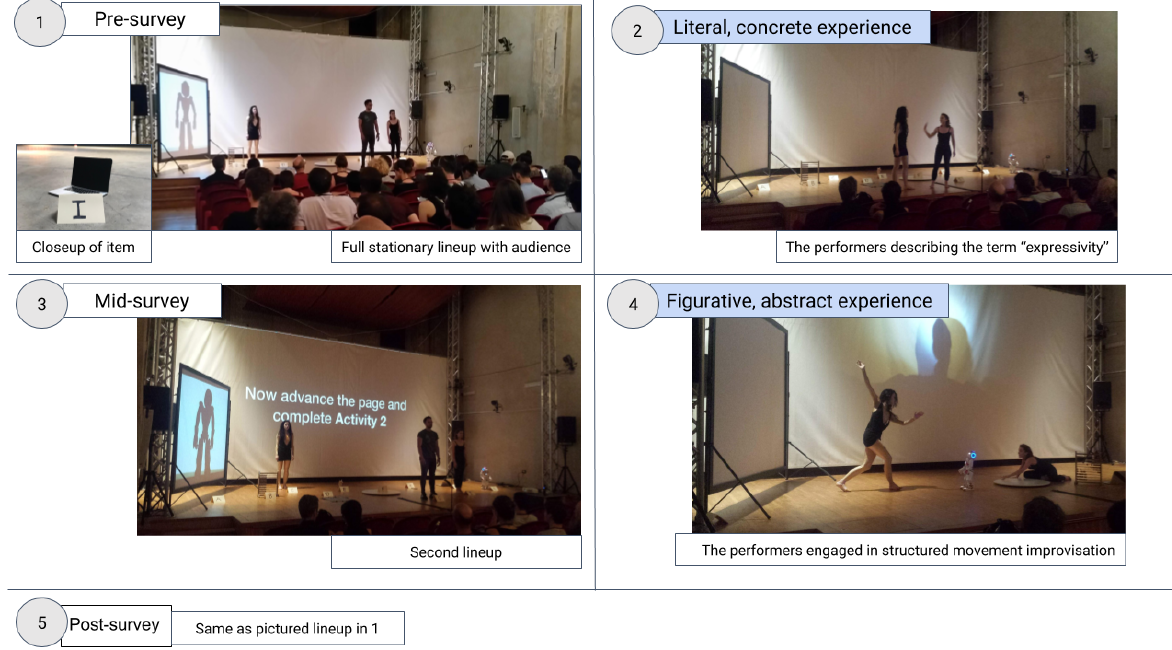
Figure 3: Pictures of the progression illustrated in Figure 2. In all images, Performer 1 is on the far left and Performer 2 is on the far right. The Male Audience Member is shown in the center of the two lineup images under Sections 1 and 3.